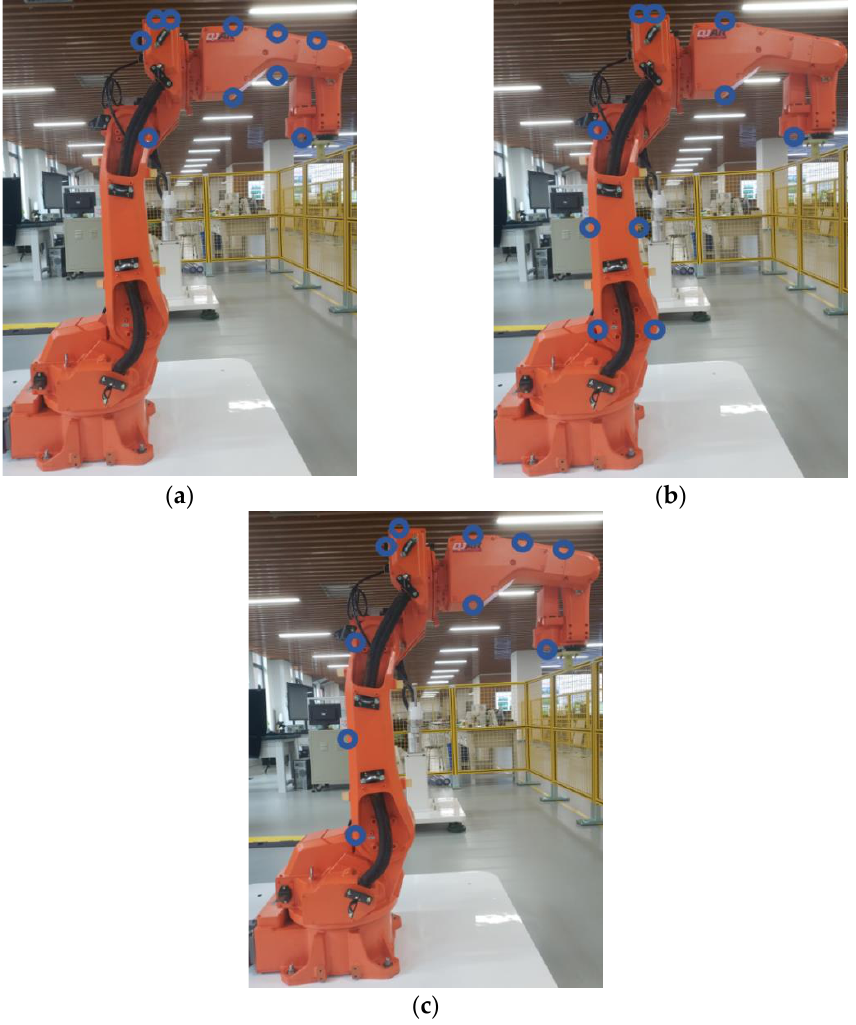
Figure 13. Three kinds of layouts for industrial robot without the simulation model: ( a ) optimal layout, ( b ) empirical layout, and ( c ) uniform layout.